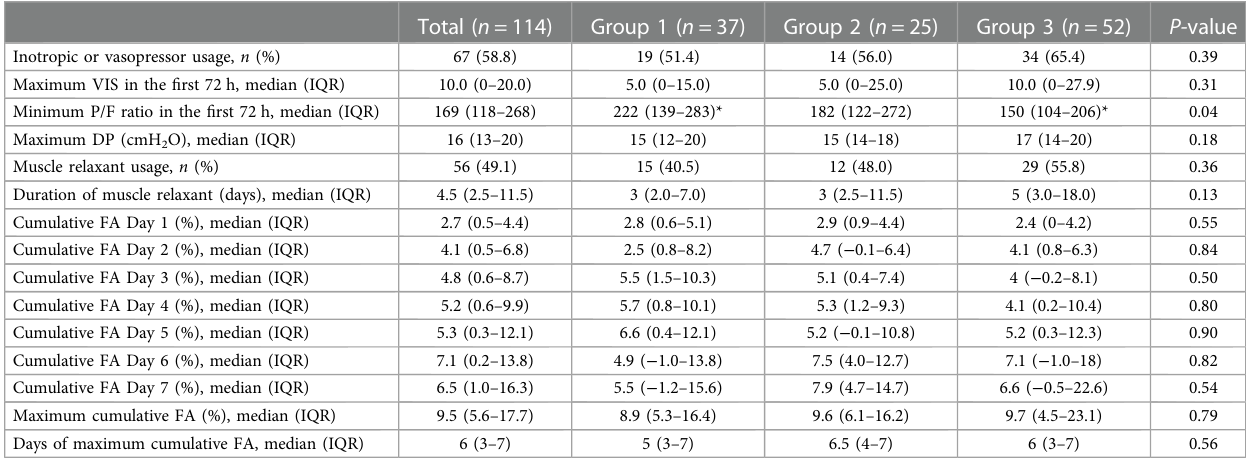
TABLE 2 Treatment